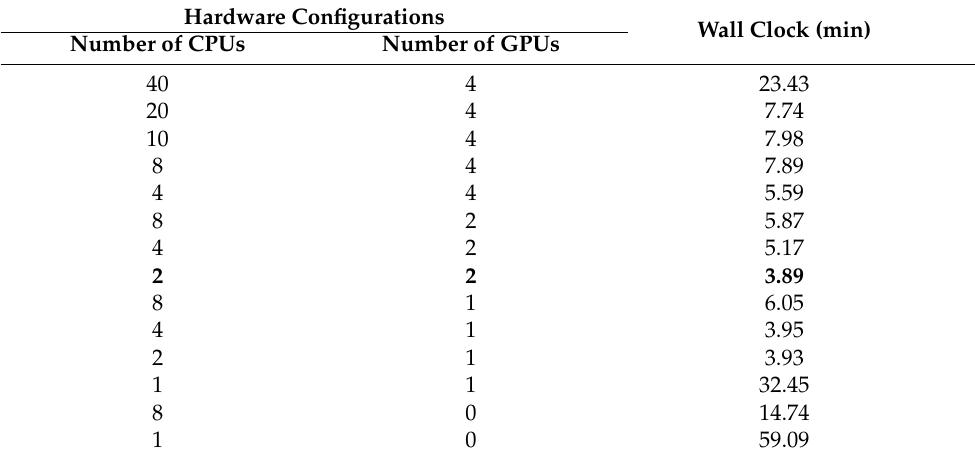
Table 1. Comparison of timings for various hardware configurations for carrying out 8 SCC iterations on protease